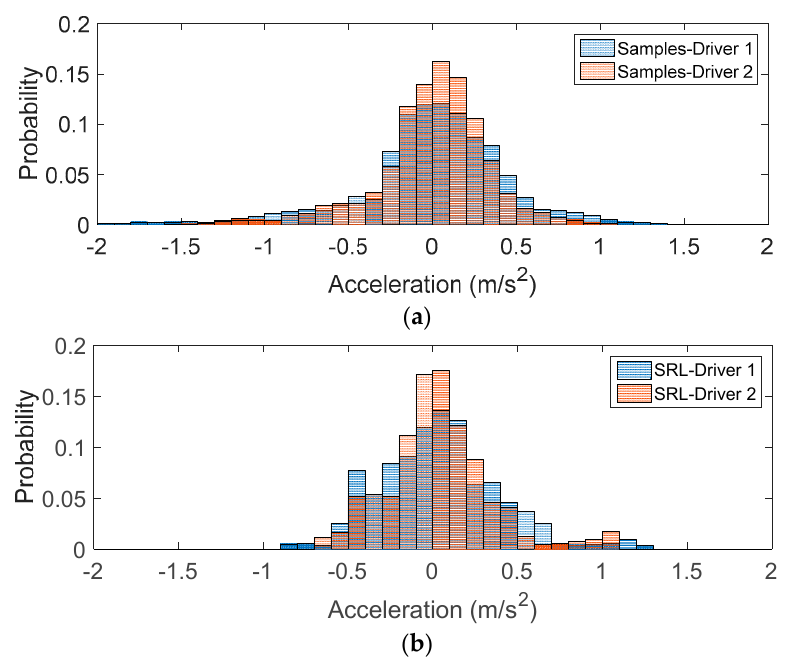
Figure 8. Acceleration distribution for the data samples ( a ) and simulation results ( b ). Table 4. Maximum, average, and variance of distance error, with the real driving cycle.